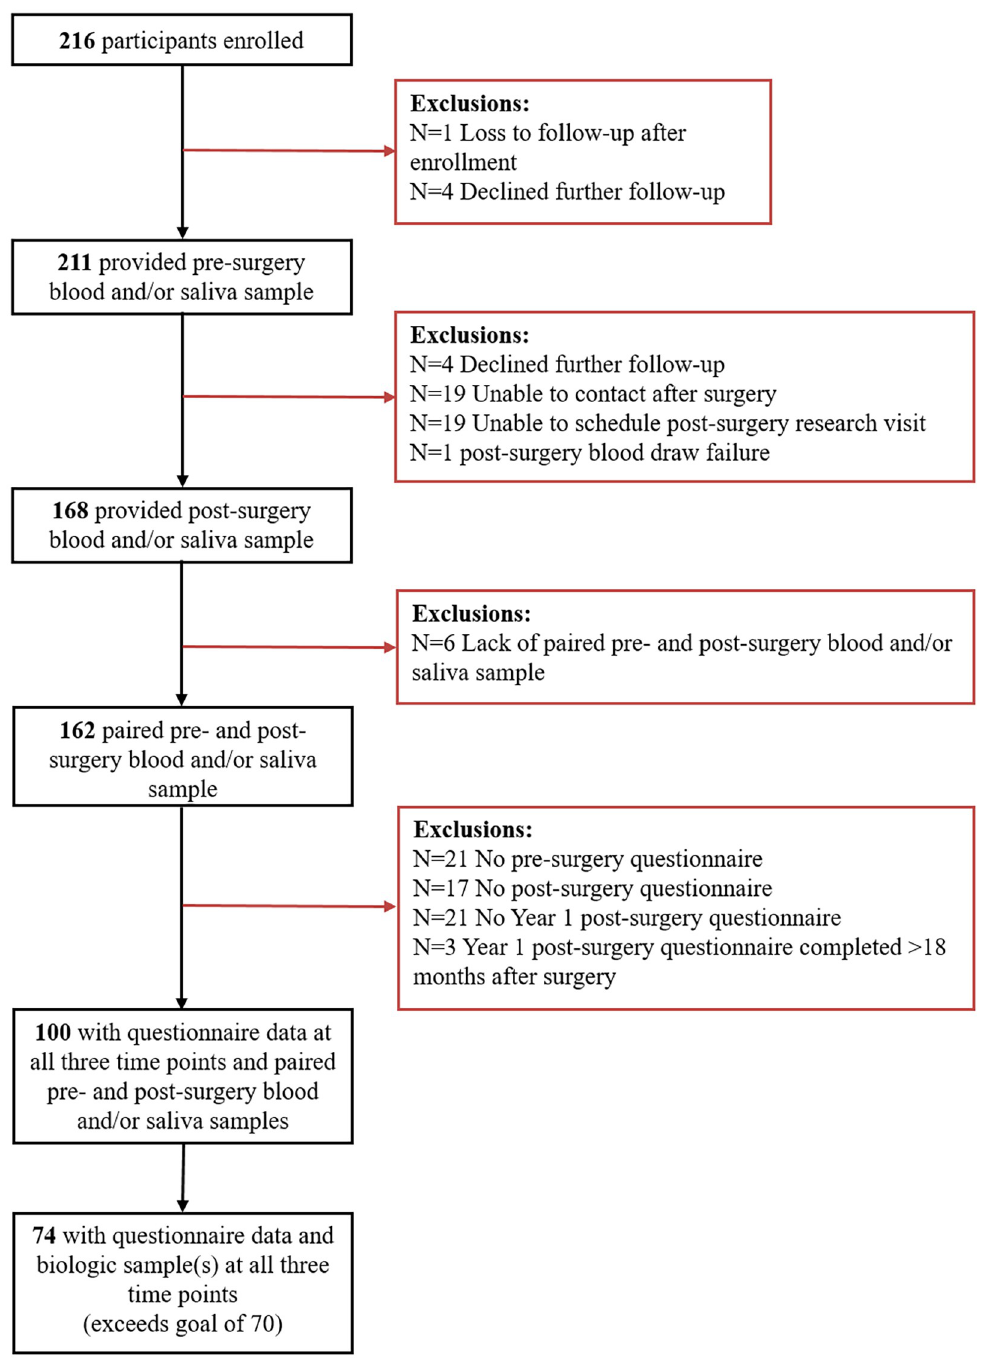
Fig 2. Inclusion (black boxes) and exclusion (orange boxes) criteria for the EndoQUEST analytic